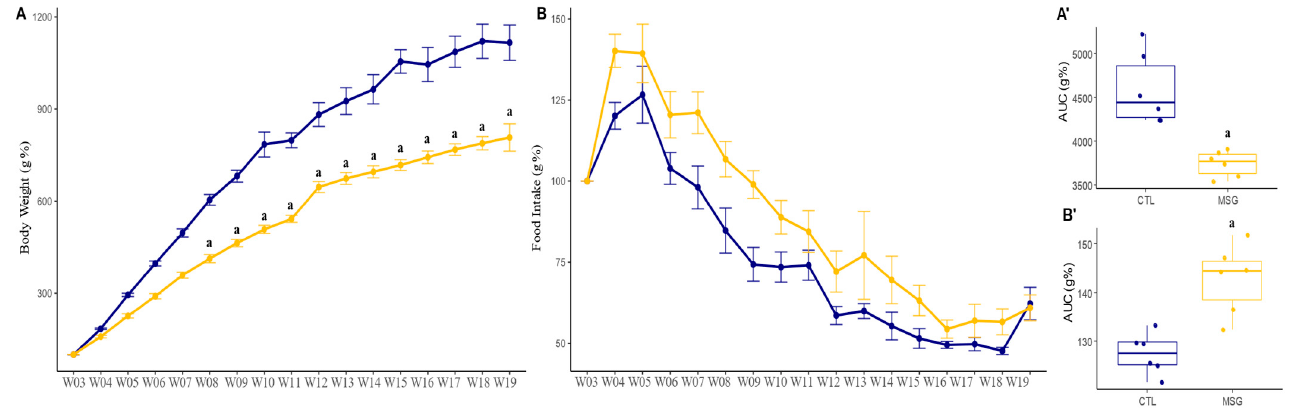
Figure 2. Graphs related to weight gain and feed consumption of CTL and the MSG animals after weaning (PND21, or W03, to PND142, or W19). ( A ): Percent weight gain line graph (g%); ( B ): line plot of food consumption (g%); ( A’ ): AUC of body weight gain; ( B’ ): AUC of food consumption (g%). The CTL is represented in blue and the MSG group is represented in yellow. The letter a represents the difference between the MSG group when compared to the CTL. ( A , B ): repeated measurements ANOVA. ( A’ , B’ ): Student’s t